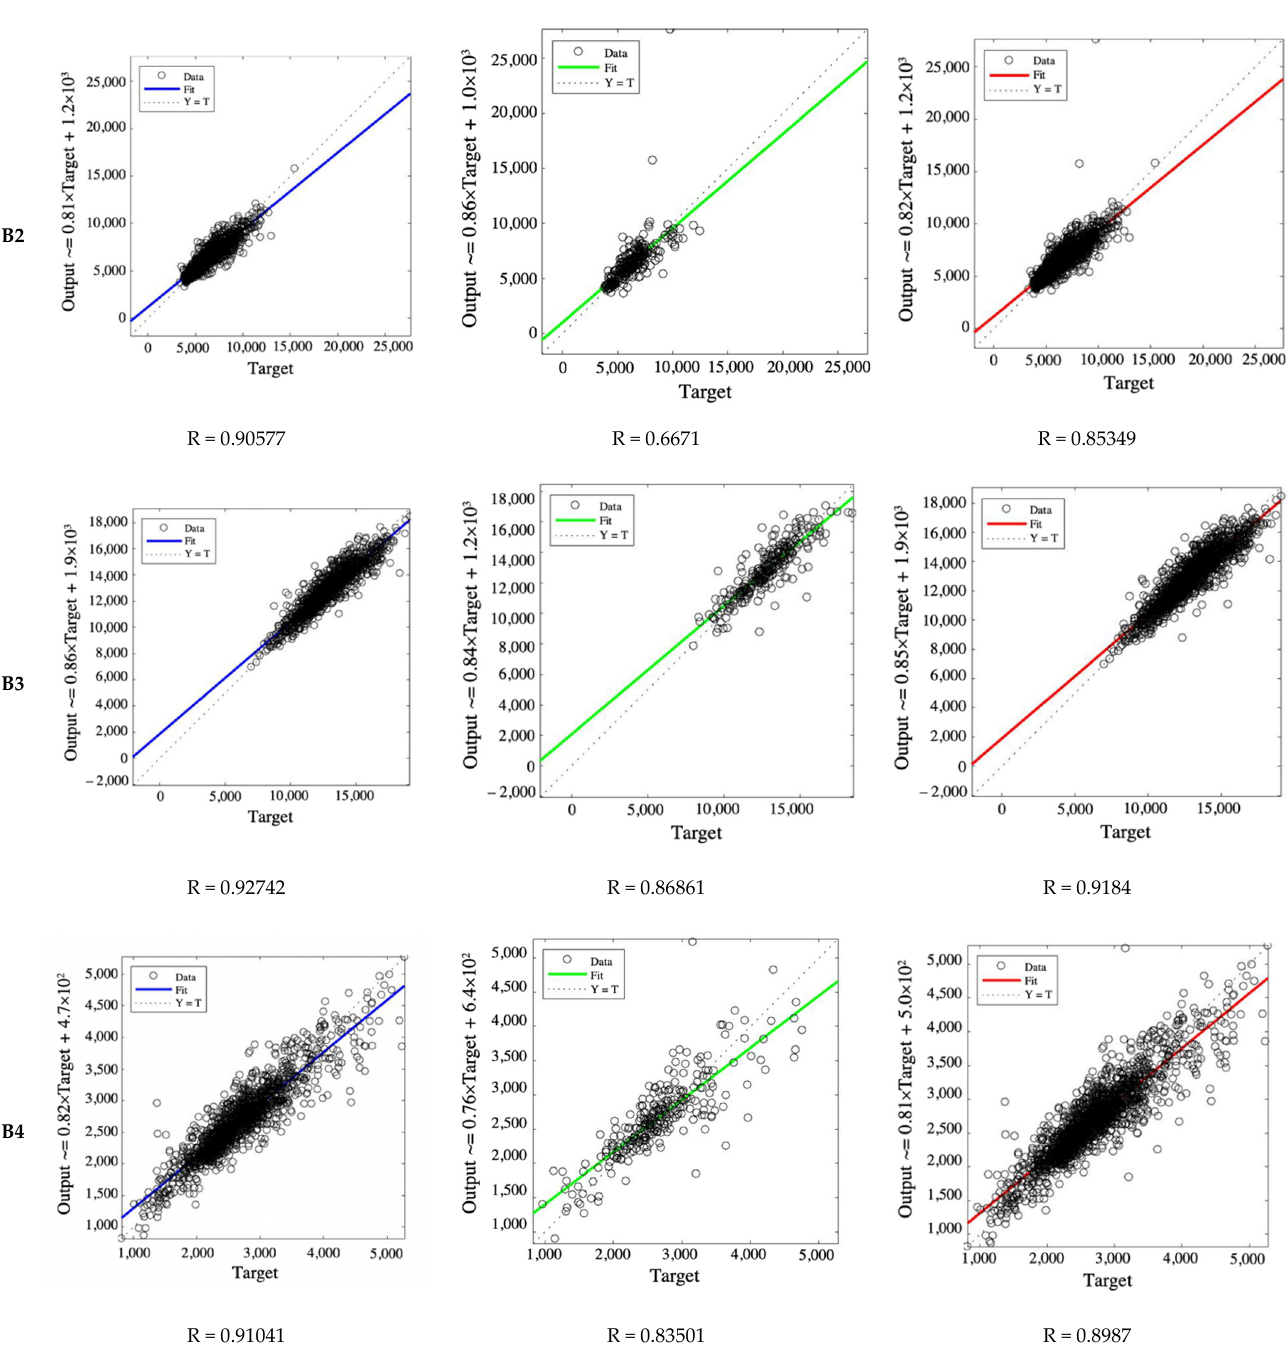
Figure 5. The NARX network outputs for the training, testing, and all datasets. After completing the network training with the training dataset and then testing with the testing dataset, the network is used to produce a complete prediction using existing datasets. Figure 6 shows the network prediction vs. actual electricity load for all buildings in this paper. Figure 6 shows that the NARX network prediction accurately maps the actual electricity load and fluctuations.